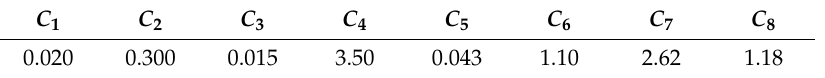
Table 6. Constants value for ε G prediction equation (Equation